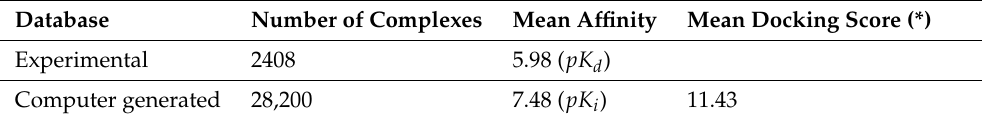
Table 1. Brief description of the experimental and the computer-generated databases. (*) The sign of the docking score is changed from negative to positive for consistency with the affinity values. These databases are freely accessible using the link in Ref.